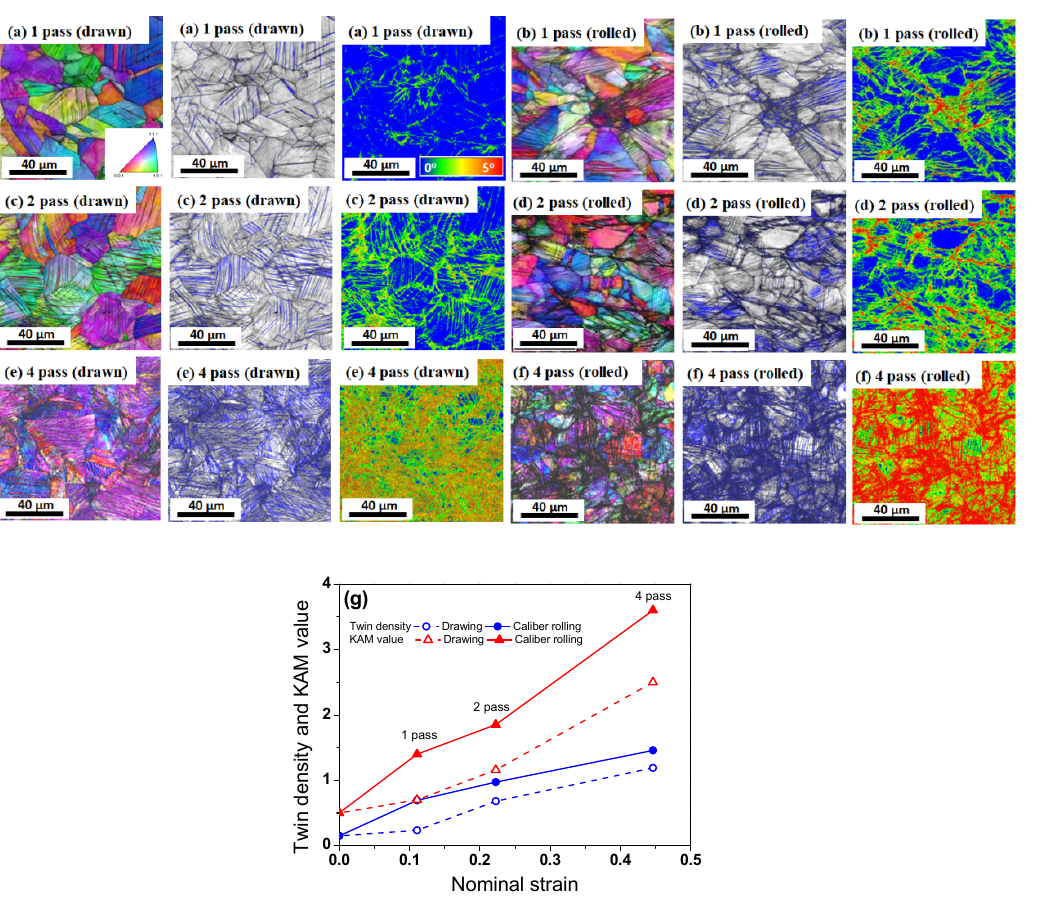
Figure 8. Comparison of the IPF, twin density, and KAM maps of ( a , c , e ) the drawn wire and ( b , d , f ) caliber-rolled TWIP steel wires with strain, and ( g ) variations in twin density and KAM value with the strain of the drawn and rolled wires. Quarter region was measured.